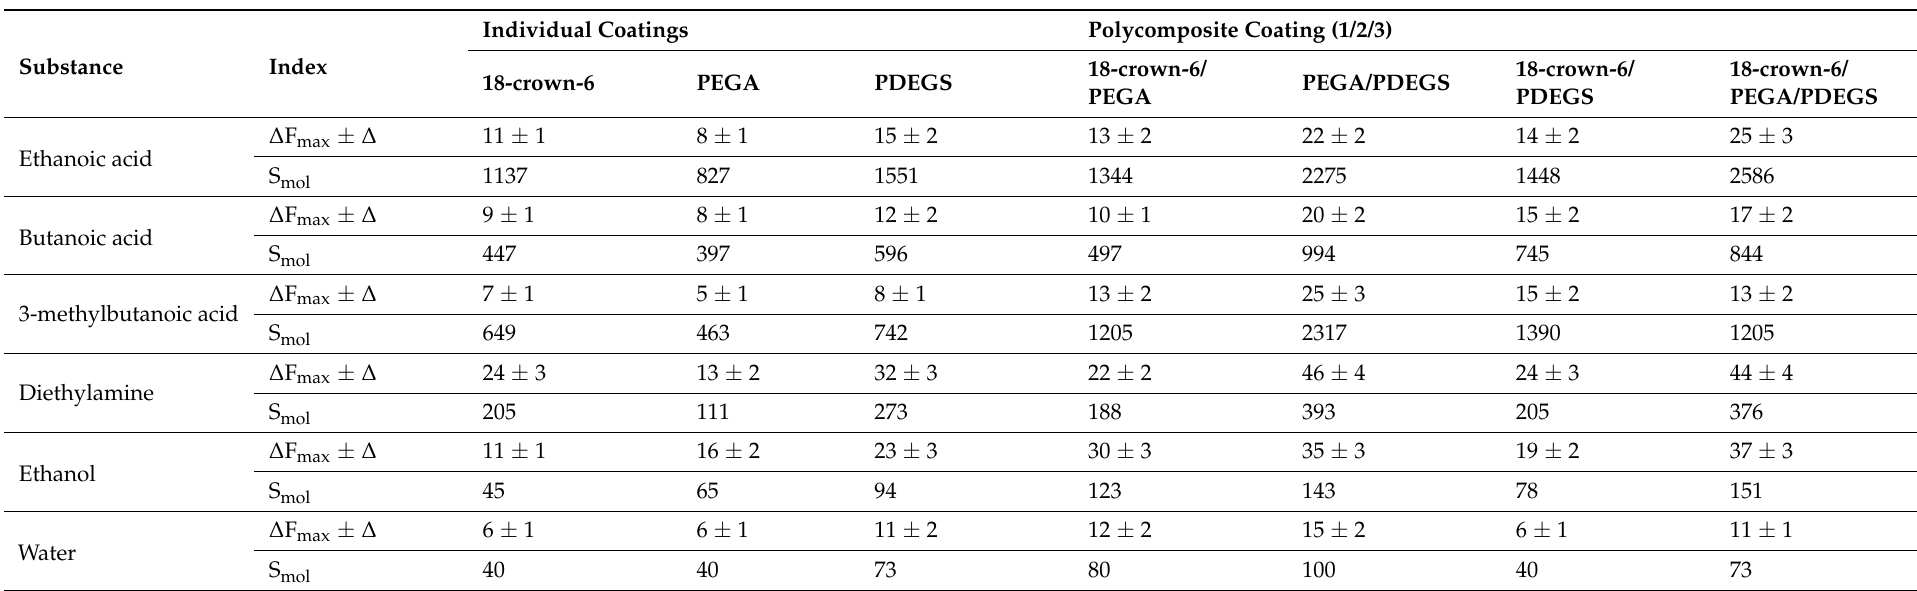
Table A1. Efficiency indicators of microweighing of vapors of test substances * by sensors with individual coatings and polycomposite